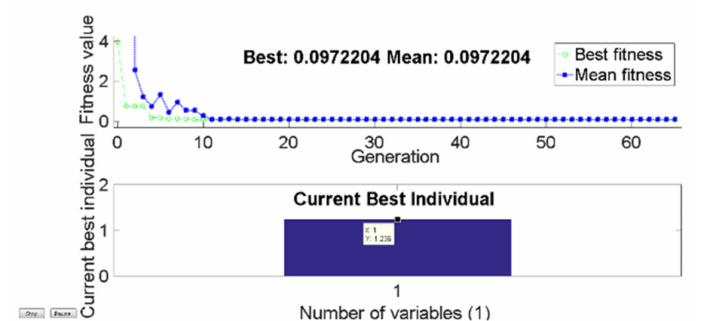
Figure 18. GA convergence characteristic results.